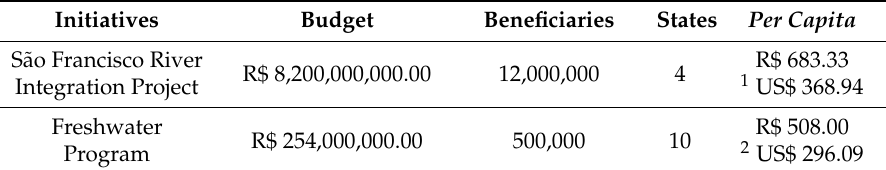
Table 6. Federal government initiatives for the water